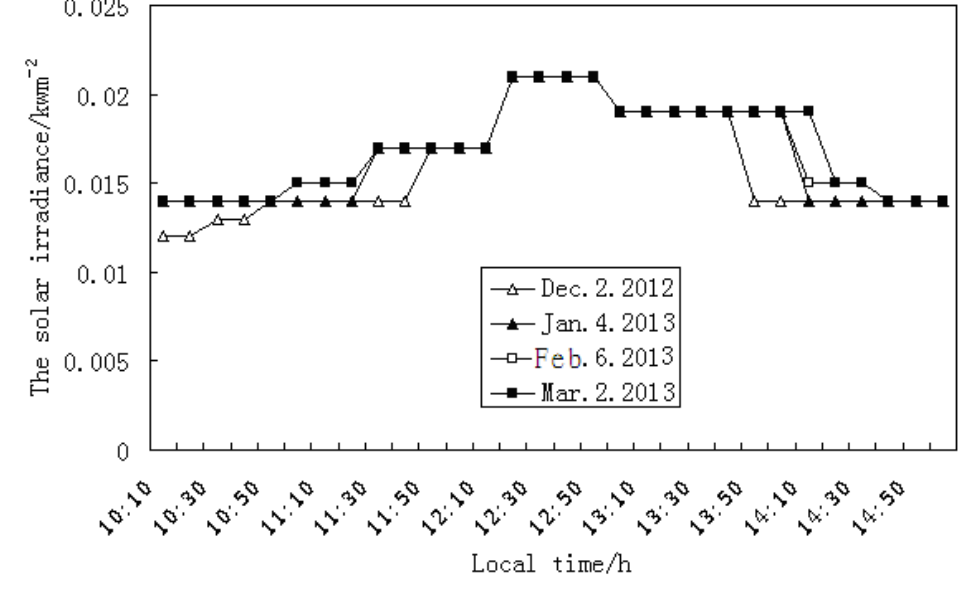
Figure 4. Amount of solar irradiance (kW/m 2 ) over time (plotted in 10-min increments) on cloudy